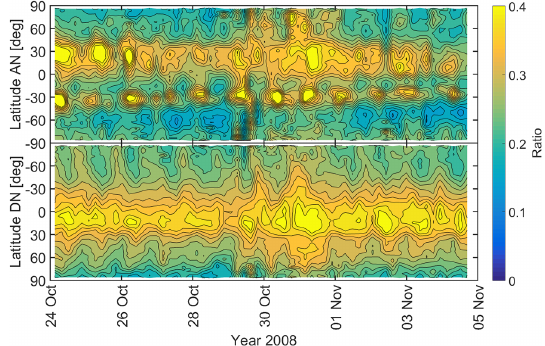
Figure 17. Electron density ratio (GITM / CHAMP) as a function of time and latitude for “case b” (LTAN = 22:50; LTDN =